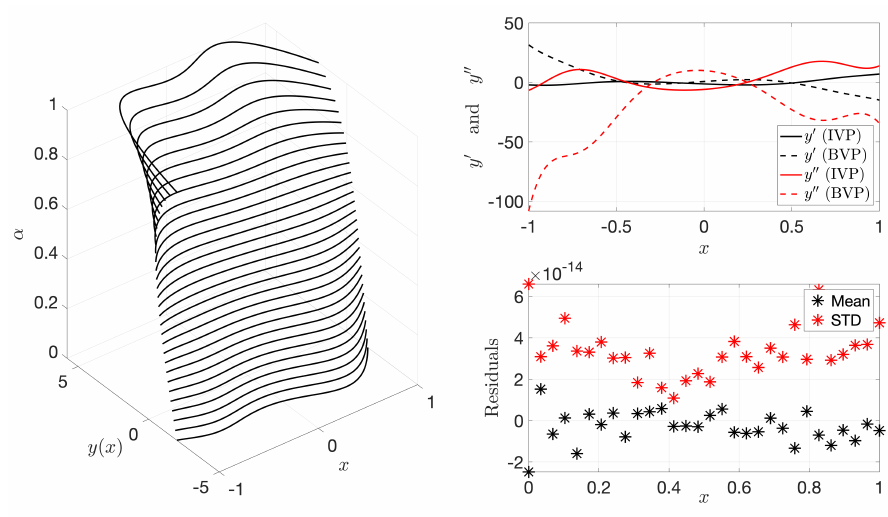
Figure 5. IVP to BVP Differential Equation parametric